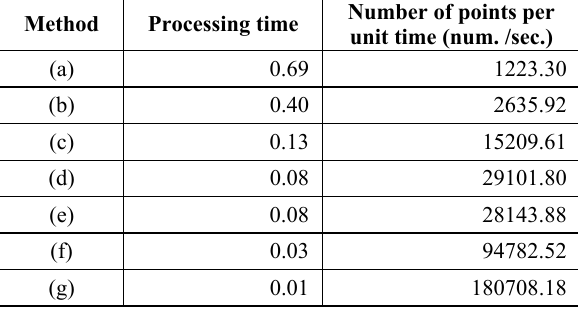
Table 8. Corresponding point extraction processing times When FAST detection was used, a relatively large number of corresponding points were extracted, such as (c) to (f) in Table 7. However, in the case of feature matching, the processing time was longer as in Table 8. Fast detection extracted more points than the Shi-Thomasi corner method, but the processing time was increased by three times as (f) and (g). Finally, we confirmed the fastest processing times when extracting feature points using the Shi-Thomasi corner method and tracking by KLT tracker and applied it to our proposed Figure 5. Fully equipped platform of KITTI